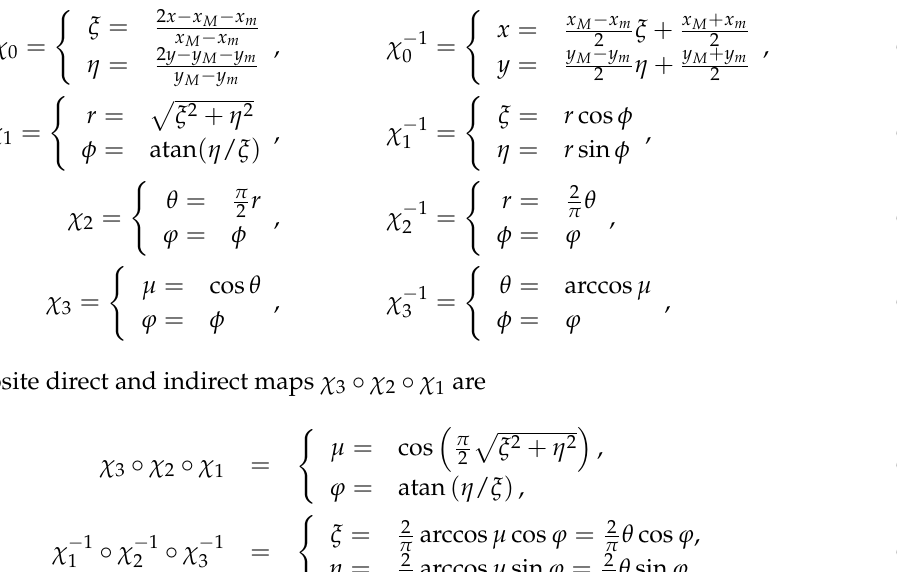
( µ , ϕ ) 1 > µ > 0 & 0 < ϕ < 2 π | {